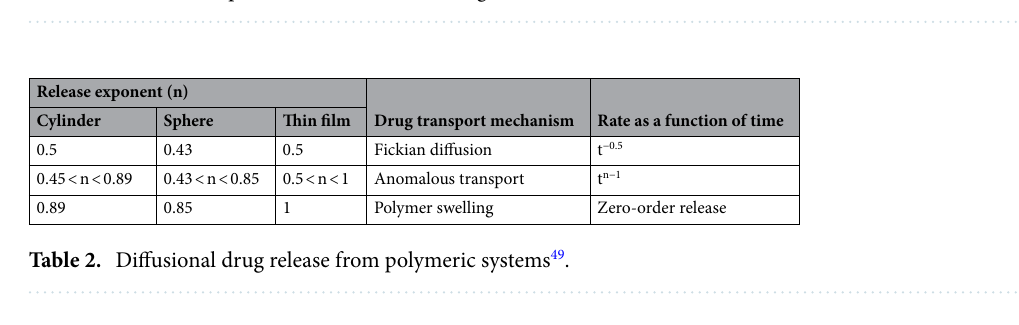
Table 1. Size (radius) and polydispersity percentage (Pd %) of the control and Tf-PEG liposomes following the 3rd and 6th LFUS pulses. Results are the average of three batches.